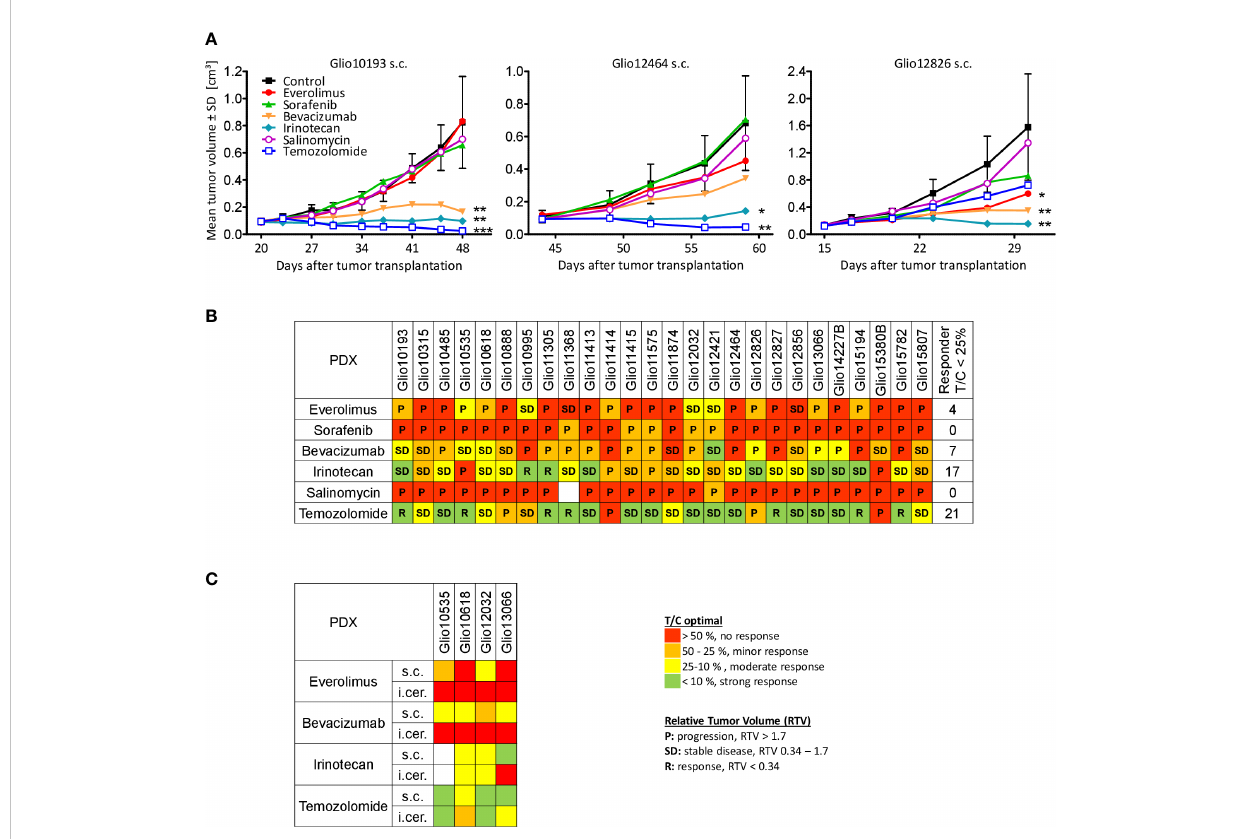
FIGURE 2 Chemosensitivity of established glioma PDX. (A) Examples of drug testings of three s.c. glioma PDX models, illustrating model-speci fi c growth characteristics and treatment responses to different drugs, like temozolomide. N=3-5. Mean and standard deviation (SD). One-way ANOVA, Dunnett ’ s multiple comparison test. Signi fi cant differences to control (PBS) at study end: * p < 0.05, ** p < 0.01, *** p < 0.001. (B) Treatment response evaluation as mean tumor volume of treated tumors divided by mean tumor volume of tumors in the corresponding control group (T/C optimal in %) revealed PDX individual sensitivity pro fi les. In addition, RTV as response criteria is indicated as progression, stable disease or regression in respective groups. N=2-6 per group. (C) T/C values at study end of orthotopic PDX models Glio10535, Glio10618, Glio12032 and Glio13066 revealed reduced sensitivities when compared to matching s.c. models. The maximum tumor area in coronal plane was used as measure for i.cer. tumor growth. RTV could not be calculated for orthotopic PDX, as tumor sizes were only measured once at study